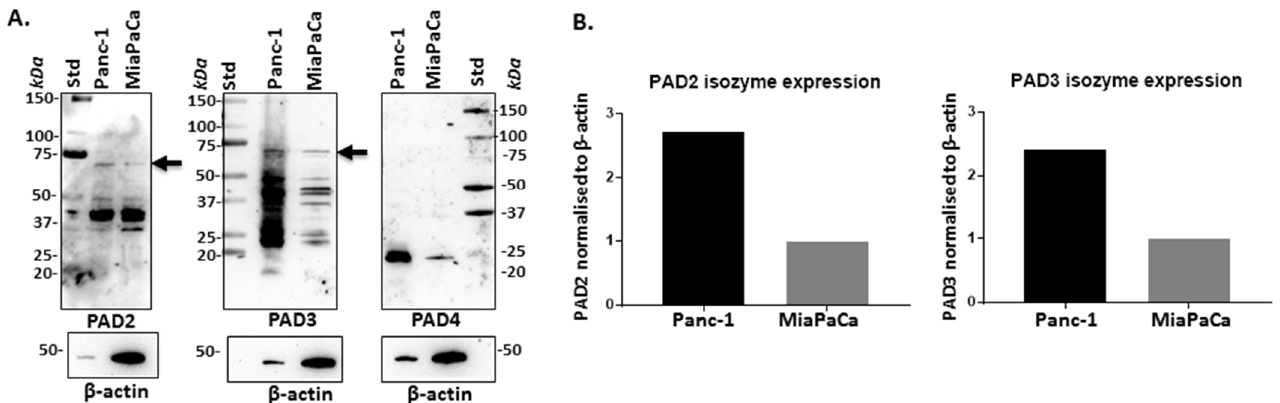
Figure 1. Peptidylarginine deiminase (PAD) isozyme expression in Panc-1 and MiaPaCa-2 cells. ( A ) PAD2 and PAD3 isoforms are detected at expected 70–75 kDa size range (arrows), although lower molecular weight bands are also observed. PAD4 isoform does not show positive at the expected size of 75 kDa, only a band at 25 kDa is observed. ( B ) PAD2 and PAD3 protein levels, normalised to internal beta-actin control, indicating that both isoforms are higher expressed in Panc-1 cells, compared with MiaPaCa-2 cells.